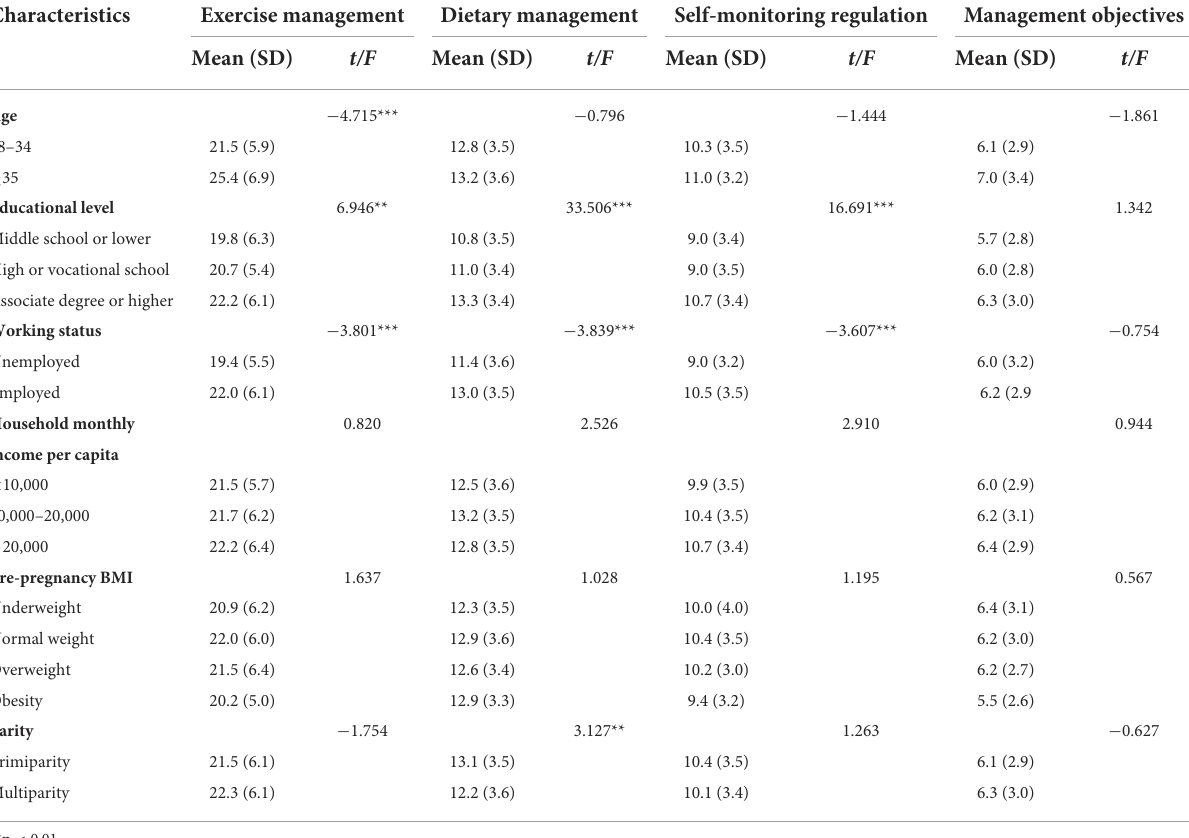
TABLE 2 Pregnancy weight management behaviors of participants with different demographic characteristics.